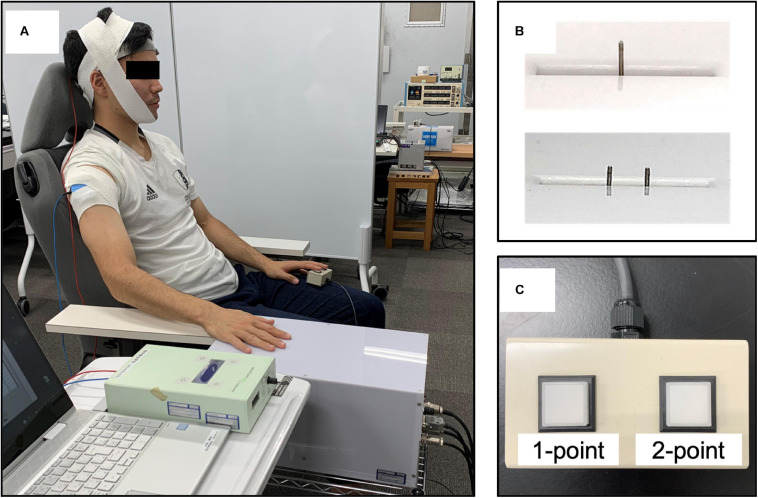
Participants’ position and the two-point tactile stimulation device. (A) The participants were seated on a fixed chair with a backrest, with the shoulder and elbow joints slightly flexed and the forearm in a pronated position. (B) The stimulus conditions (stimulus speed, 10.0 mm/s; stimulus penetration depth, 1.0 mm; stimulus presentation time, 1.0 s; and stimulus interval, 5 s) were fixed, and pin spacing was randomly assigned (one point, 0 mm and two points, nine different places, ranging from 1.0 to 5.0 mm at 0.5-mm intervals) using a custom-made computer-controlled two-point tactile stimulation device. (C) Answer button: participants were asked to respond about whether they perceived two points only when they were confident that there were two points, and an uncertain stimulus or one point was classified as one point.